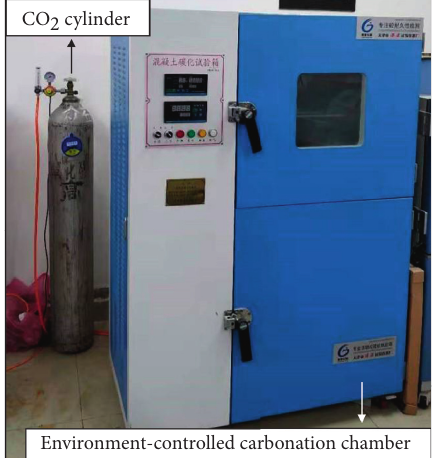
Figure 3: Environment-controlled carbonation chamber adopted in this study.